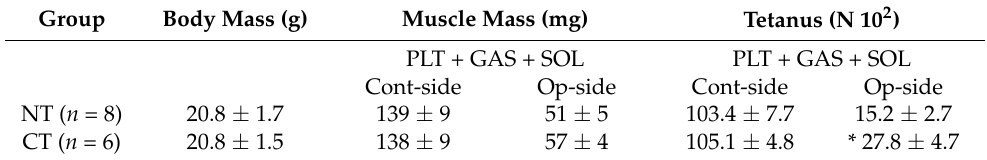
Table 1. Body and muscle mass, and muscle tension output.